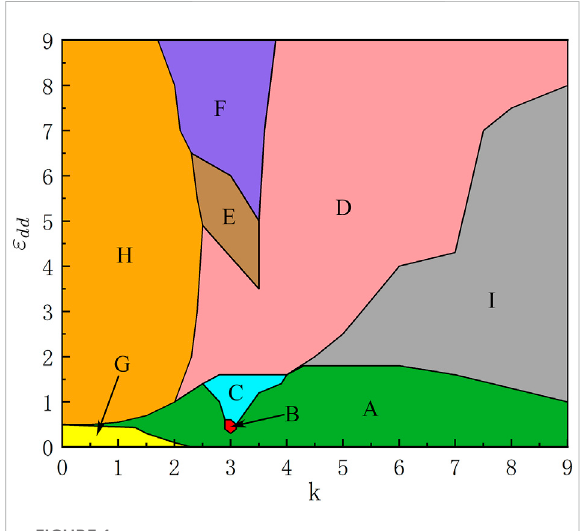
FIGURE 1 (Color online) Ground-state phase diagram of the Dresselhaus spin-orbit-coupled dipolar BECs in an anharmonic trap with respect to k and ε dd for β 11 = 50, β 22 = 100 and β 12 = 150. There are nine different phases marked by (A – I)